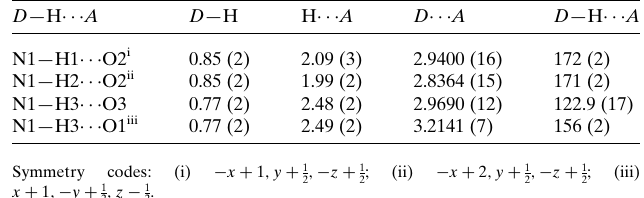
Table 2 Hydrogen-bond geometry (A˚ , (cid:5) ).